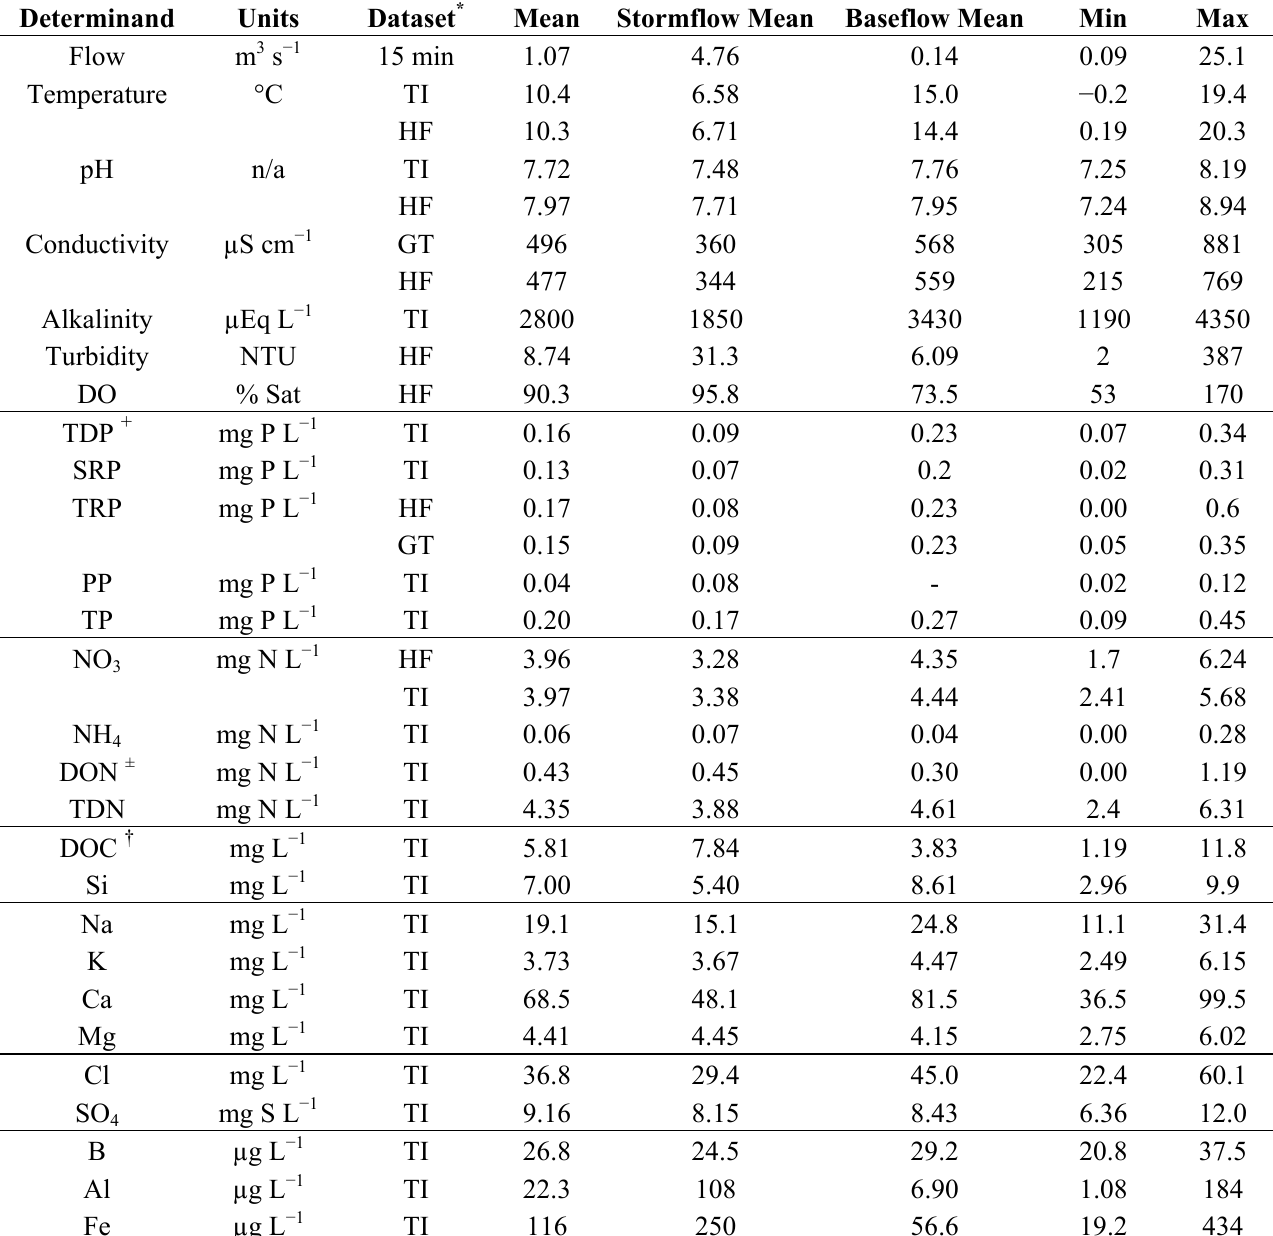
Table 7. Water quality statistics for the River